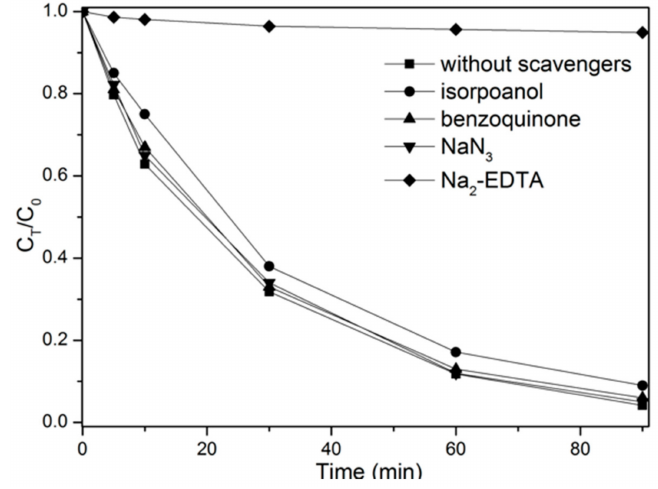
Figure 7. Photocatalytic activities of Ag@Ag 2 O-G2 in the reactive species scavenging experiments under visible